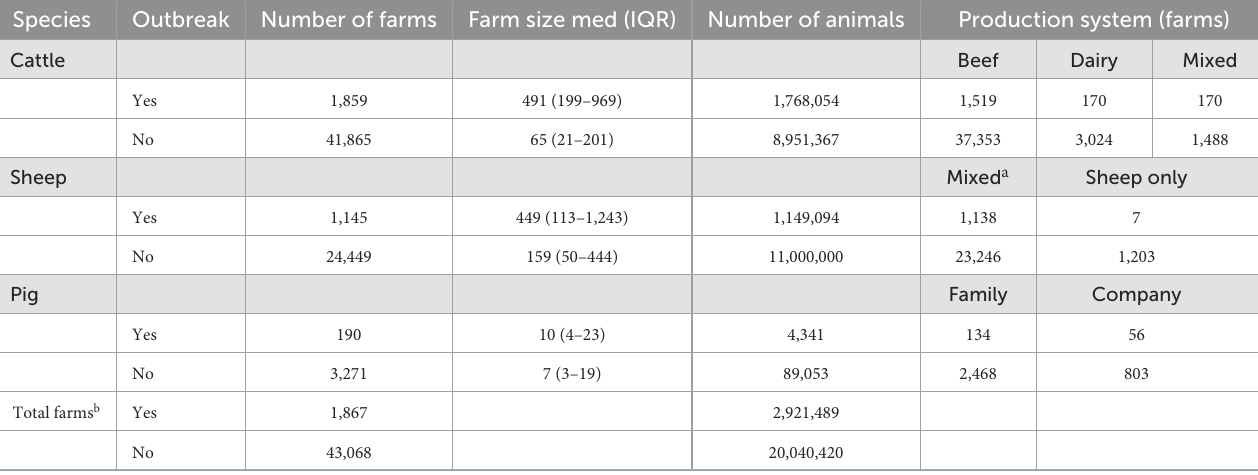
TABLE 1 Number of outbreaks and uninfected farms during the entire epidemic considering the species kept, the farm size distribution and the production system within